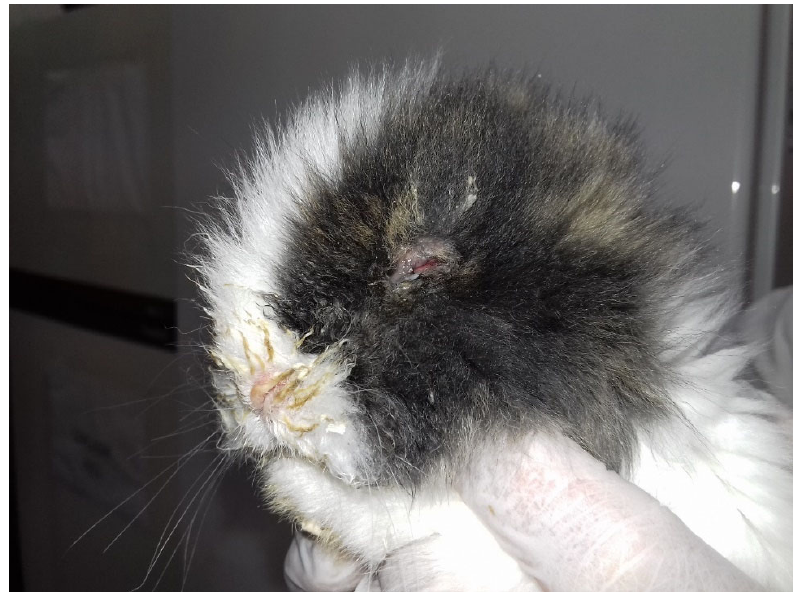
Figure 1. Left side of a bunny with severe clinical signs. Note the swollen eyelids and the purulent discharge on the hair around the